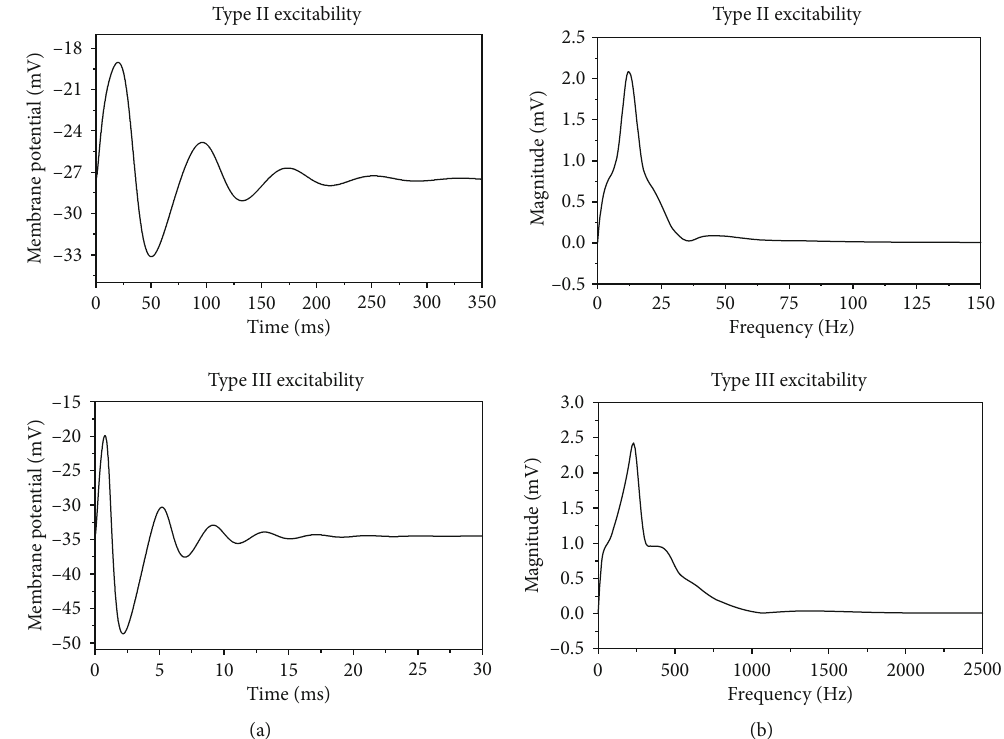
Figure 4: The membrane potential (a) and the corresponding spectrum (b). (a1, a2) Type II excitability. The subthreshold oscillations corresponding to the dashed curve in Figure 1(b). (b1, b2) Type III excitability. The subthreshold oscillations corresponding to the dashed curve in Figure 1(c).